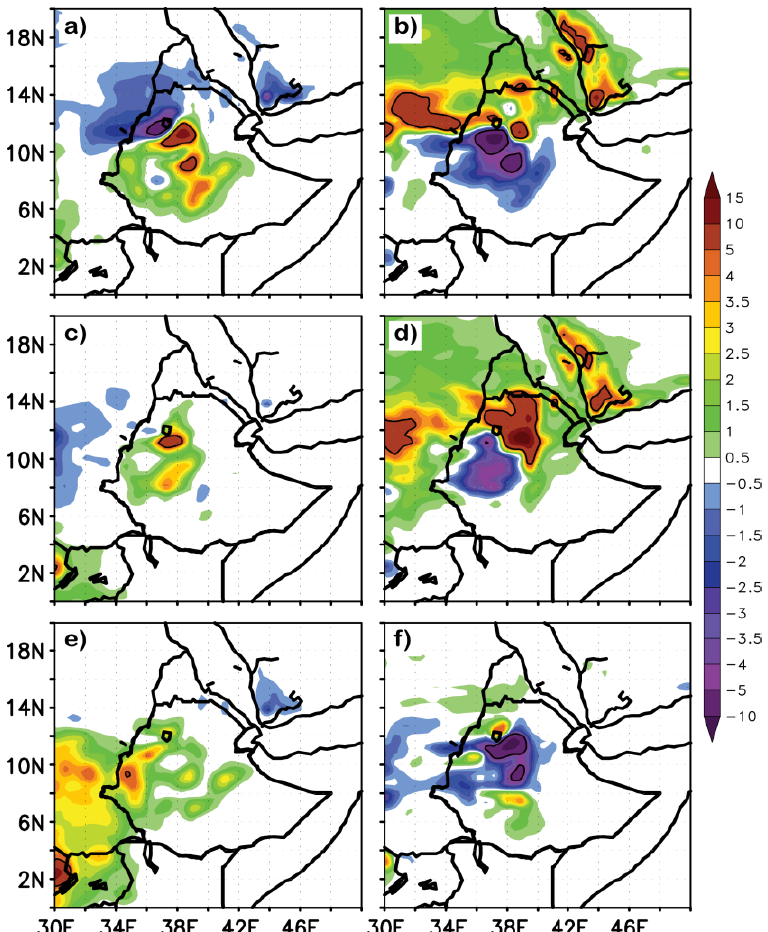
Figure 5. July-August simulated rainfall rate (mm·day −1 ) ensemble differences from CNTRL for ( a ) 2K sea surface temperature (SST) warming over the Northern Indian Ocean (NIO), ( b ) 2K cooling over the NIO, ( c ) linearly eastward decreasing SST over the Equatorial Indian Ocean (EIO), ( d ) linearly eastward increasing SST over the EIO, ( e ) 2K SST warming over the Southern Indian Ocean (SIO), and ( f ) 2K SST cooling over the SIO. See Figure 2 for ocean basin definition. See Table 1 for description of